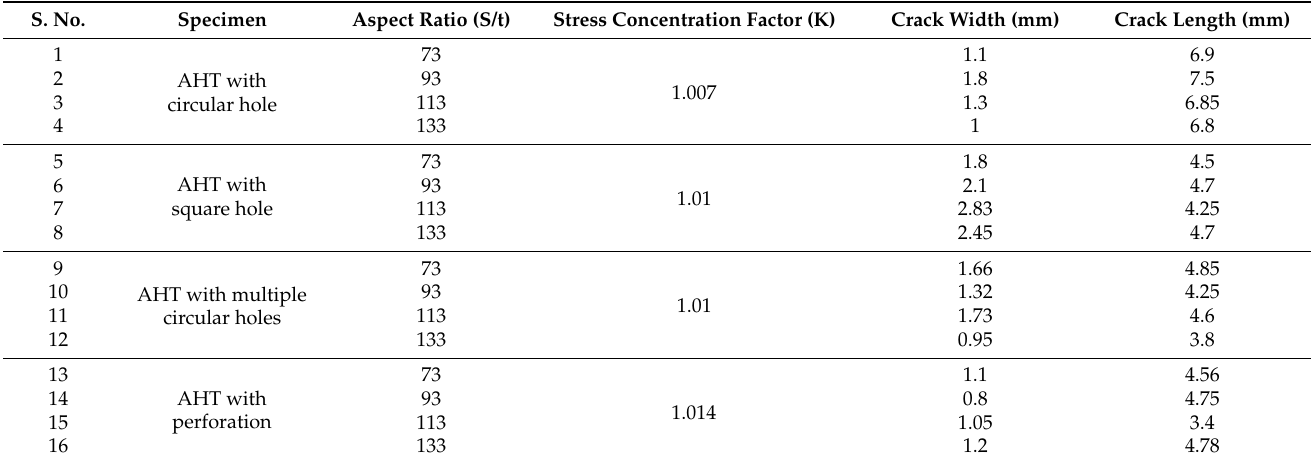
Figure 6. Crack dimensions of flexural failed specimens. Table 4. Numerical flexural performance measures.